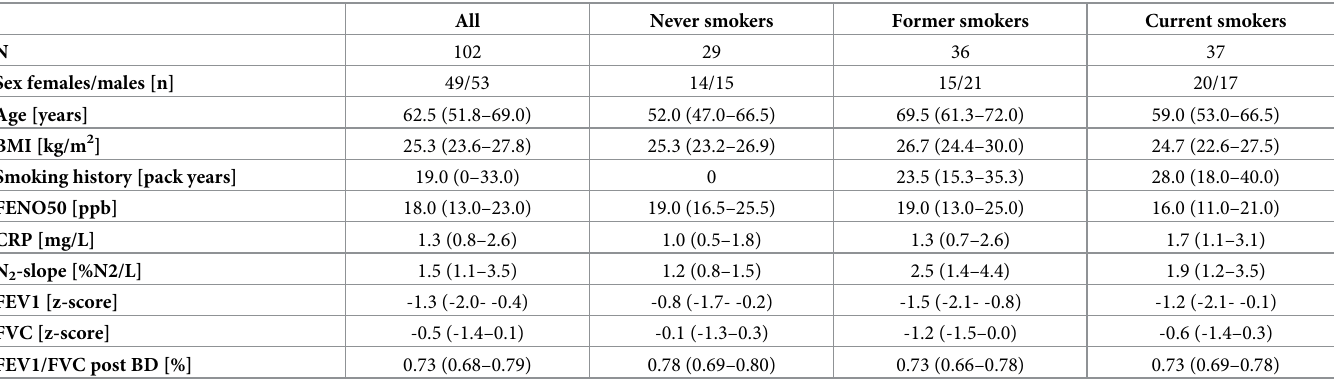
Table 1. General and clinical characteristics of study population, subdivided according to smoking